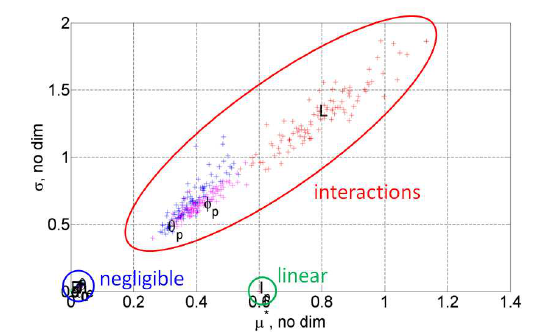
Figure 11: RV ranging from screening design based upon Tab. 4.